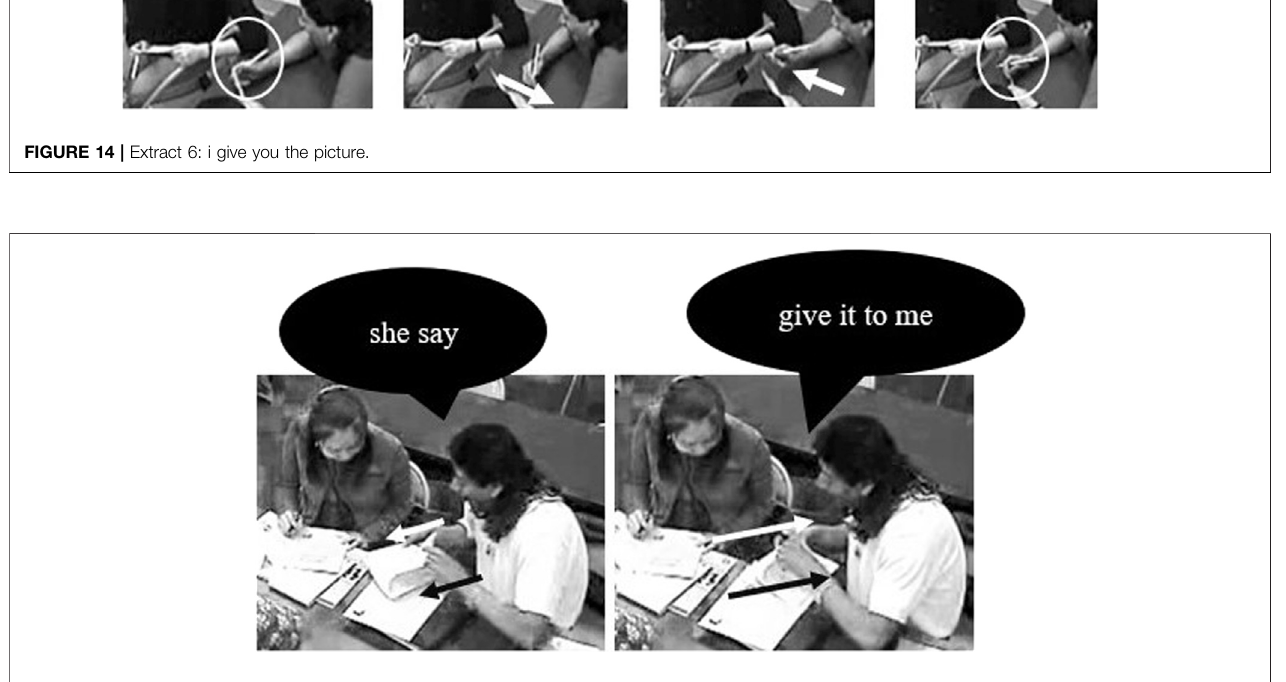
FIGURE 15 | Extract 7. line 2: she say give it to me.